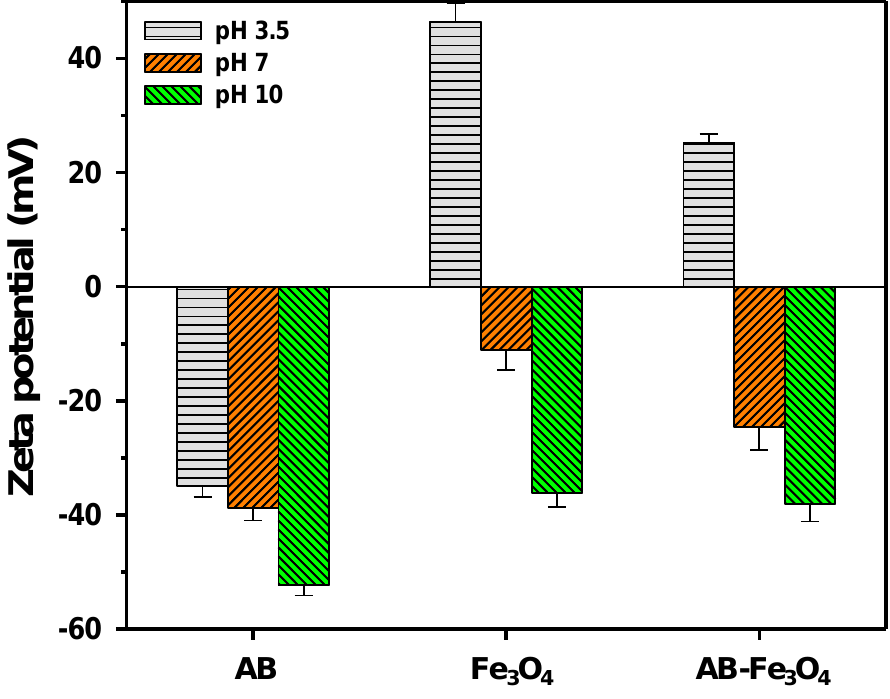
Figure 4. Variations in the surface (zeta) potential of AB, Fe 3 O 4 , and AB-Fe 3 O 4 with solution pH (pH 3.5, 7, and 10) at 298 K. Error bars indicate the standard deviations for at least triplicate measurements.